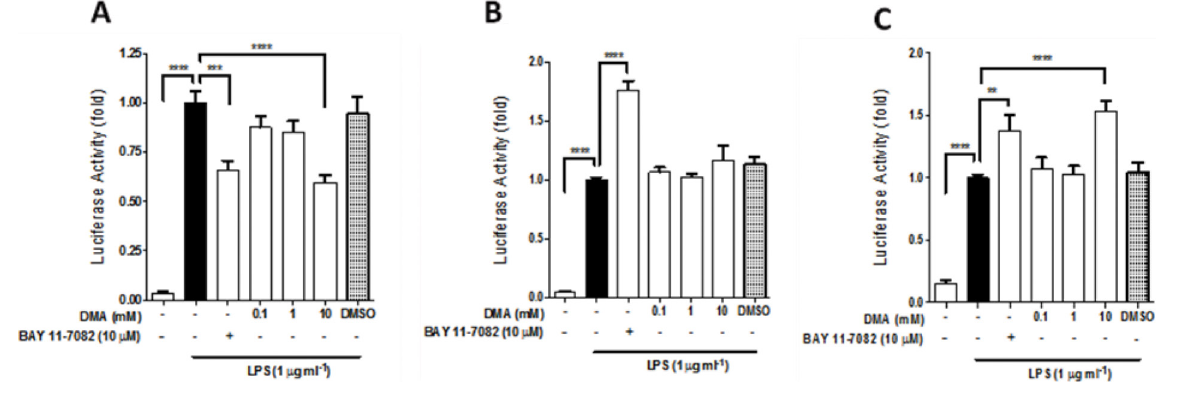
Figure 6. DMA decreases transcriptional activity of NF- κ B but not AP-1 or C/EBP. Luciferase activity was evaluated using the DualGlo luciferase reagent system after DMA and BAY 11-7082 in LPS-stimulated HEK 293/TLR4 cells transiently transfected with (A) NF- κ